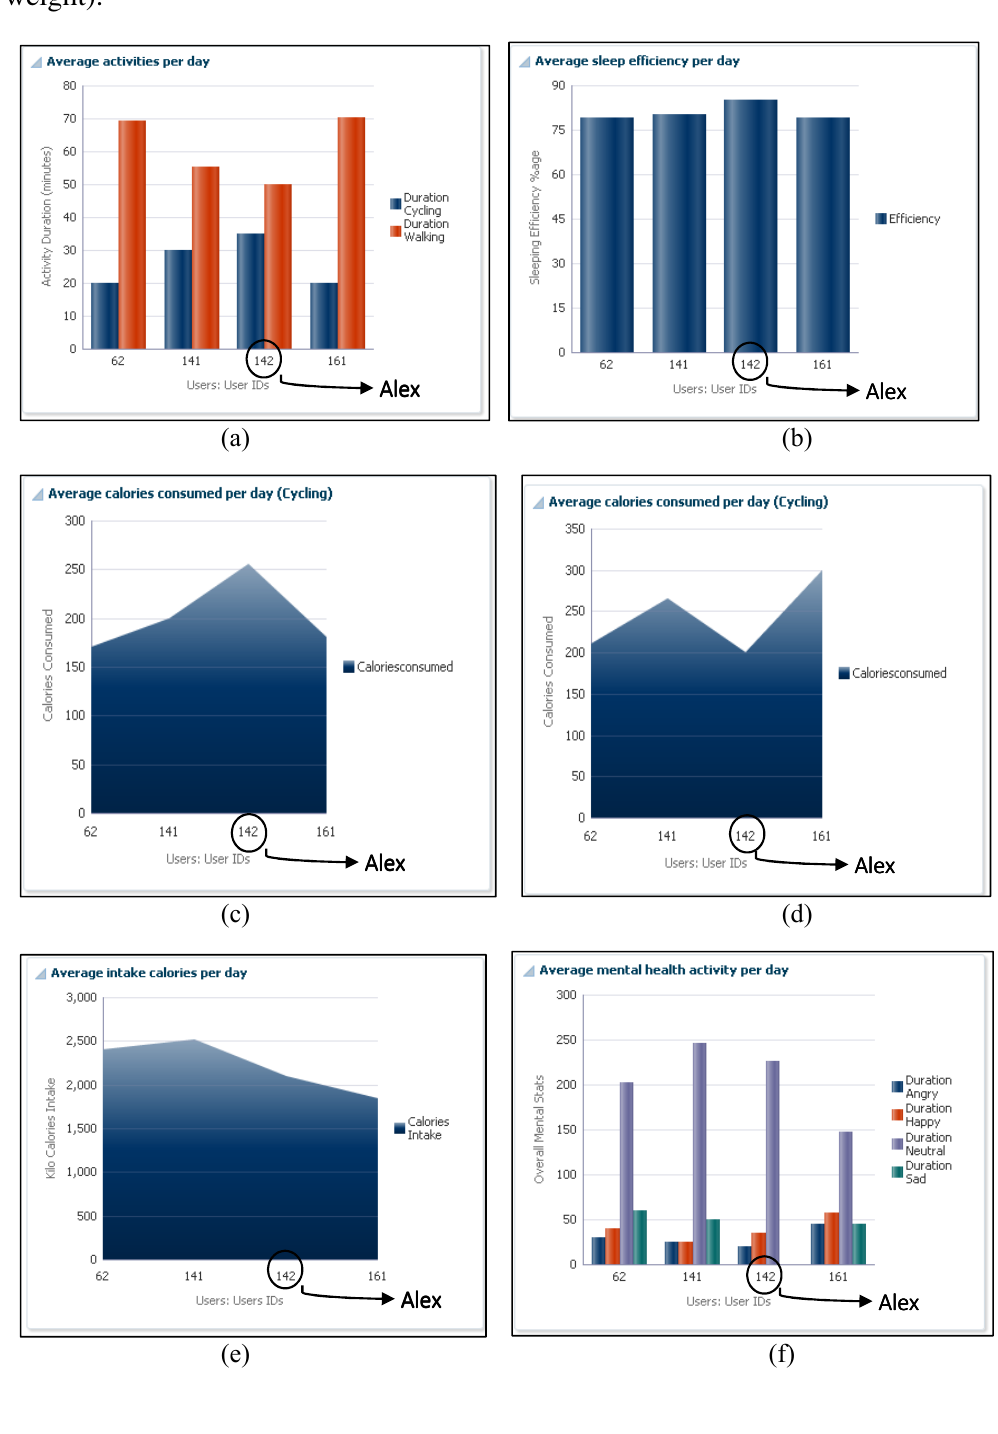
Figure 7. Health primitive comparison with the same group of people (age, height, and